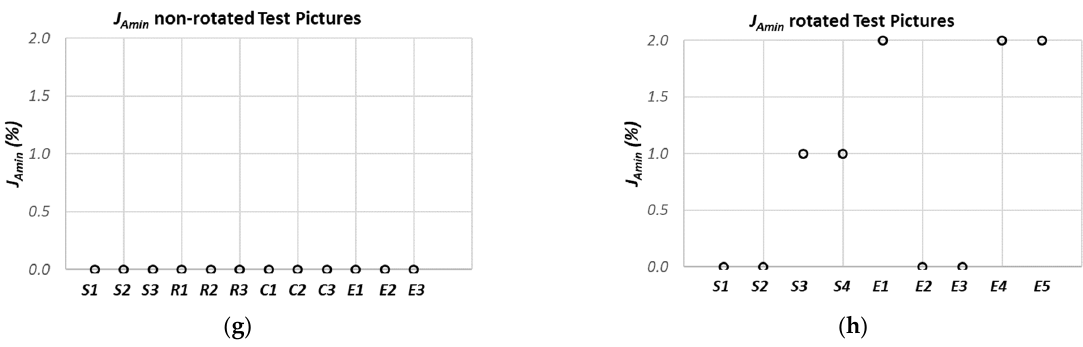
Figure 6. Behavior of Indexes (1)–(4) as a function of the test particles: ( a , c , e , g ) reference image, ( b , d , f , h ) rotated image. Particle legend: S = square, R = rectangle, C = circle, E = ellipse.